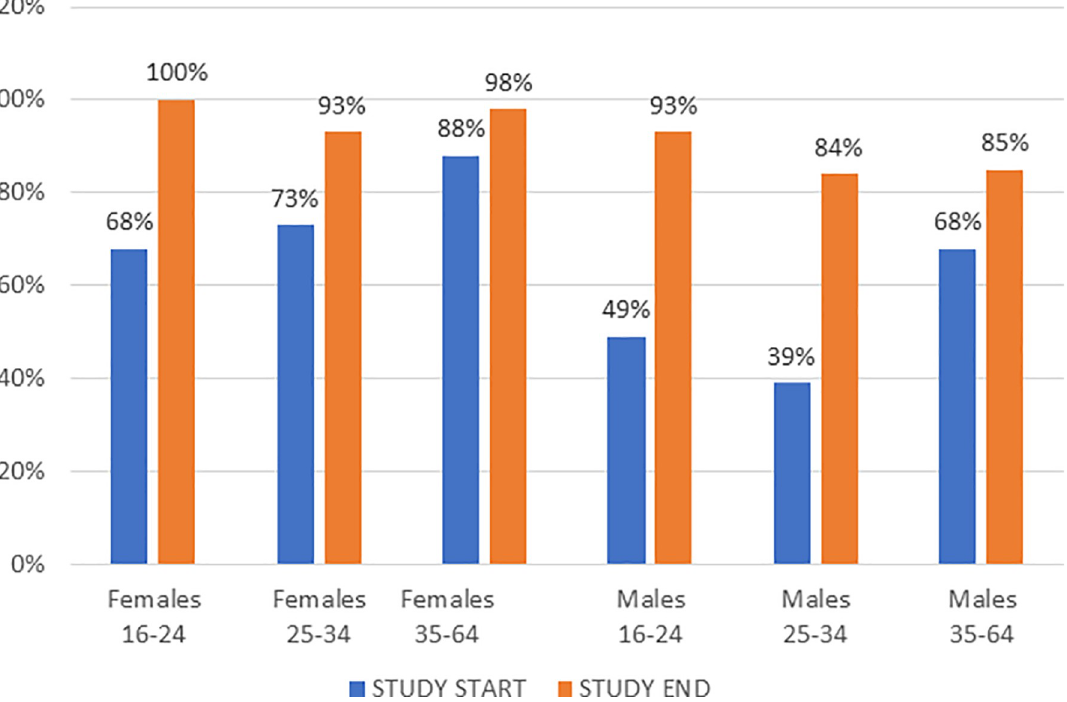
Fig 4. Increases in population-level knowledge of HIV-positive status from study start to study end in the intervention communities by sex and age.